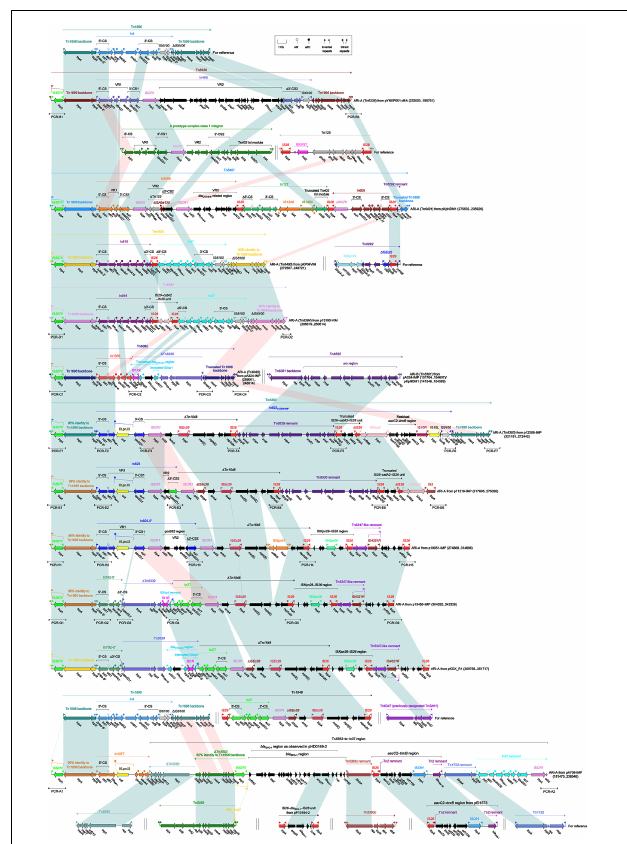
FIGURE 3 | Organization of ARI-A islands and comparison to related regions. Genes are denoted by arrows. Genes, mobile elements and other features are colored based on their functional classification. Shading denotes regions of homology (nucleotide identity > 95%). Numbers in brackets indicate nucleotide positions within corresponding plasmids. The accession numbers of Tn 1696 (Partridge et al., 2001), Tn 125 (Poirel et al., 2012), Tn 6292 (Wei et al., 2016), Tn 1548 (Galimand et al., 2005), Tn 6347 , Tn 5563 (Yeo et al., 1998), Tn 5053 (Kholodii et al., 1993), IS 26 – bla SFO − 1 –IS 26 unit (Sun et al., 2016), Tn 5393c (L’Abée-Lund and Sørum, 2000), aacC2 – tmrB region (Partridge et al., 2012), and Tn 1722 (Allmeier et al., 1992) for reference are U12338, JN872328, KU886034, AF550415, CP000447, U88088, L40585, KX710093, AF262622, JX101693, and X61367, respectively. Arrowheads indicated location of PCR primers and expected